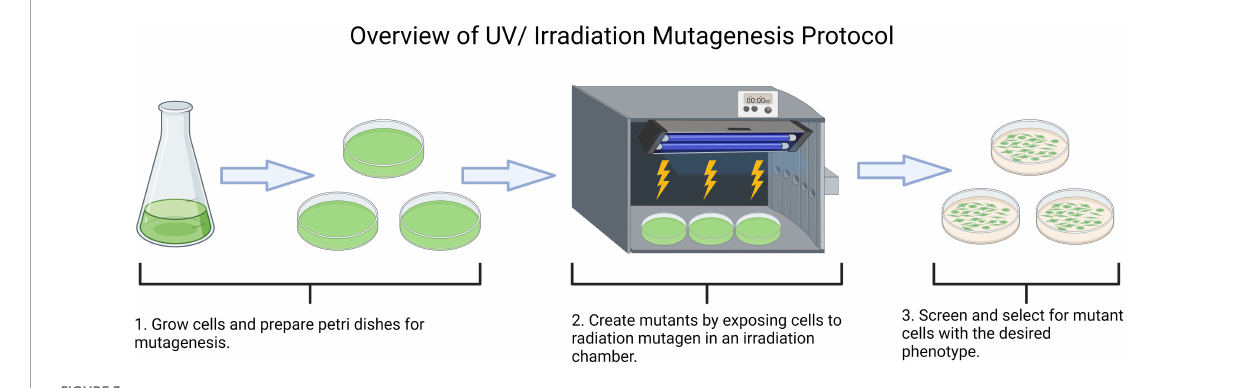
FIGURE3 Irradiation (UV) mutation, screening, and selection of microalgae cells (Created with Biorender.com).